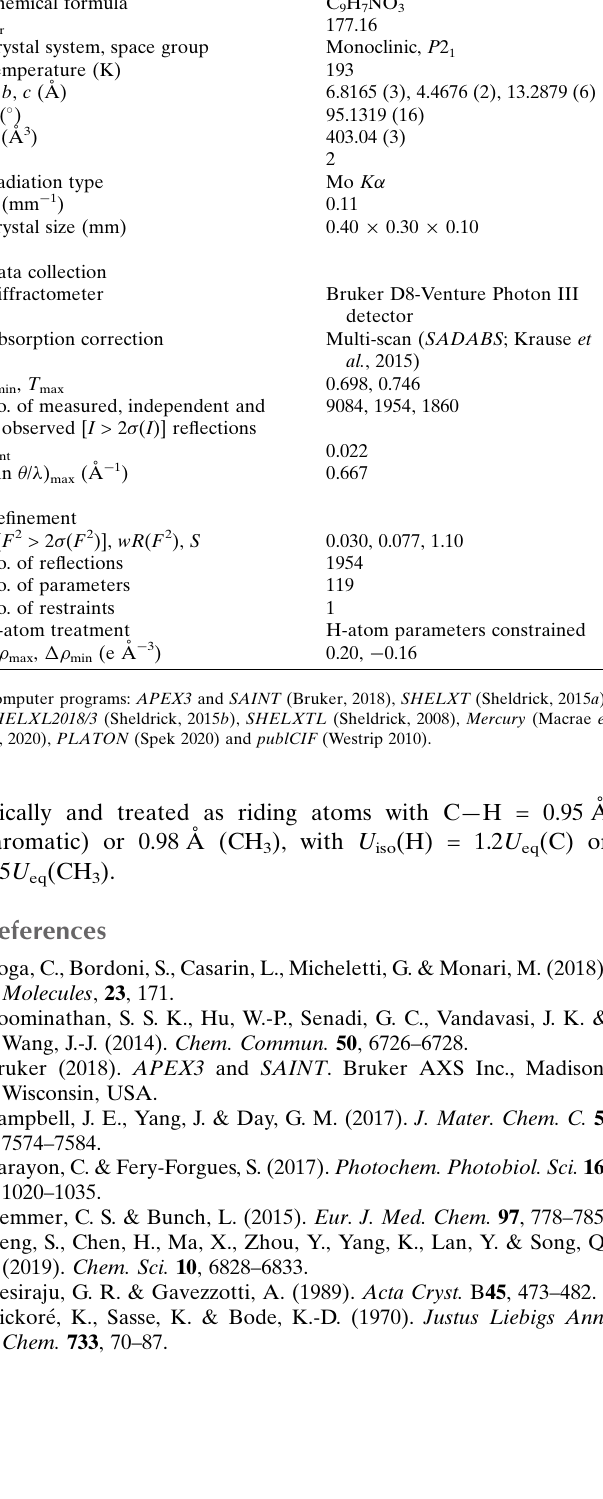
Table 4 Experimental details. Crystal data Chemical